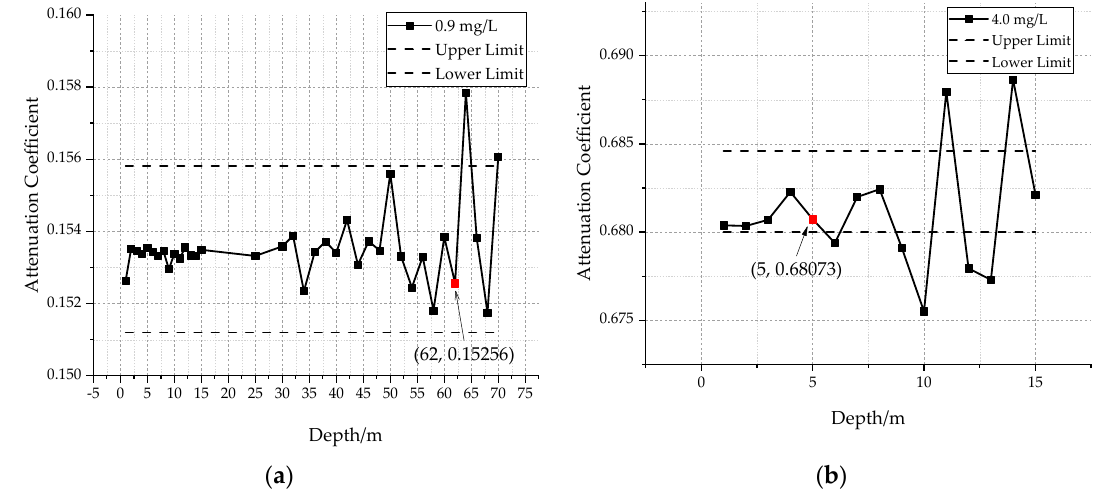
Figure 3. The mean of the extinction coefficients at different transmission depths for seawater containing suspended matter concentrations of ( a ) 0.9 mg/L and ( b ) 4.0 mg/L. It can be seen that the extinction coefficient still fluctuates near a fixed value. For a given concentration, the fluctuation of the extinction coefficient increases with increasing transmission depth. When the transmission depth exceeds a threshold, the extinction coefficient fluctuates strongly, which is because the number of remaining photons is too small. The fluctuation of extinction coefficient is considered reasonable only when the statistical error can be ignored.